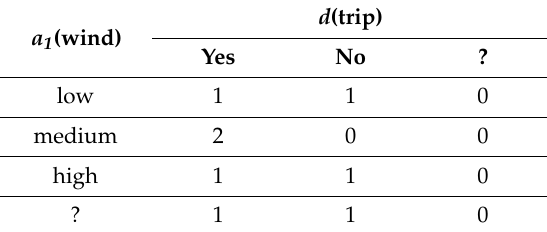
Table 10. Frequency table of a1 with respect to d .